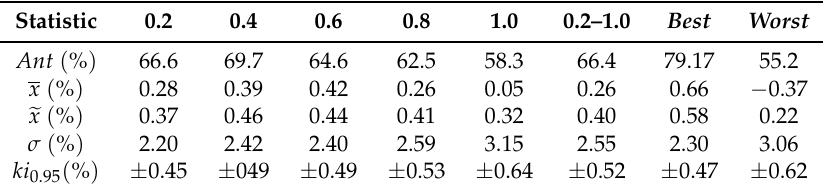
Table 2. Relative saving potential initial copy rate for generating the copied population compared to randomized